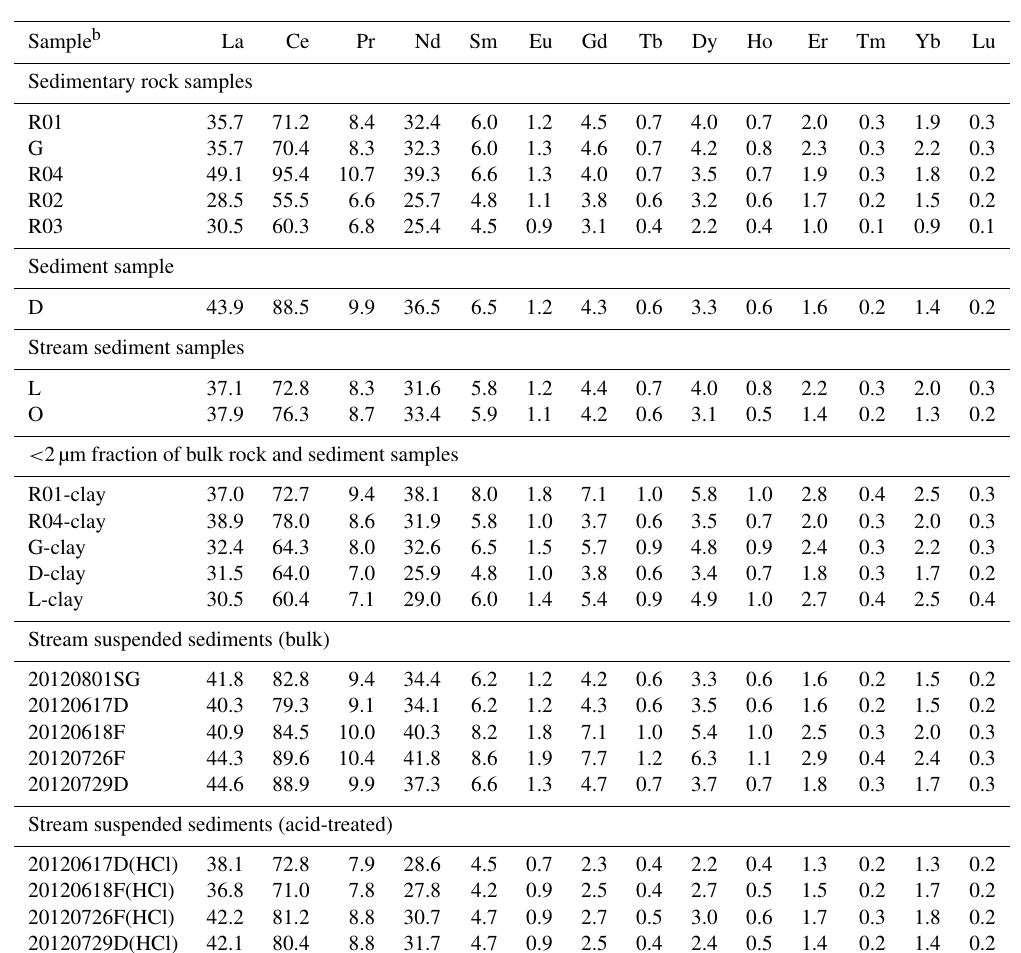
Table A2. Rare earth element concentrations in mgkg − 1 , a , b